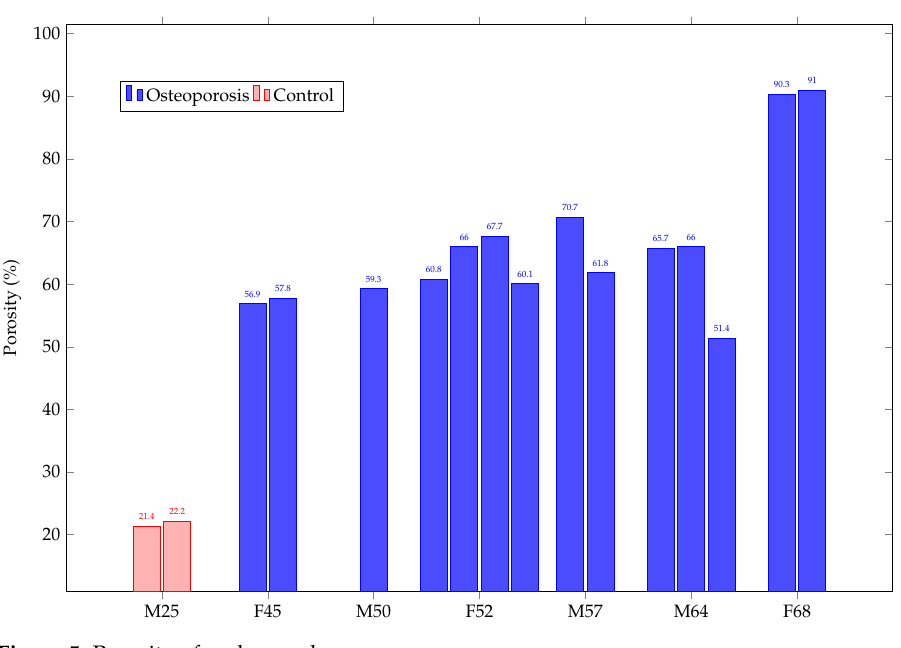
Figure 5. Porosity of each sample.